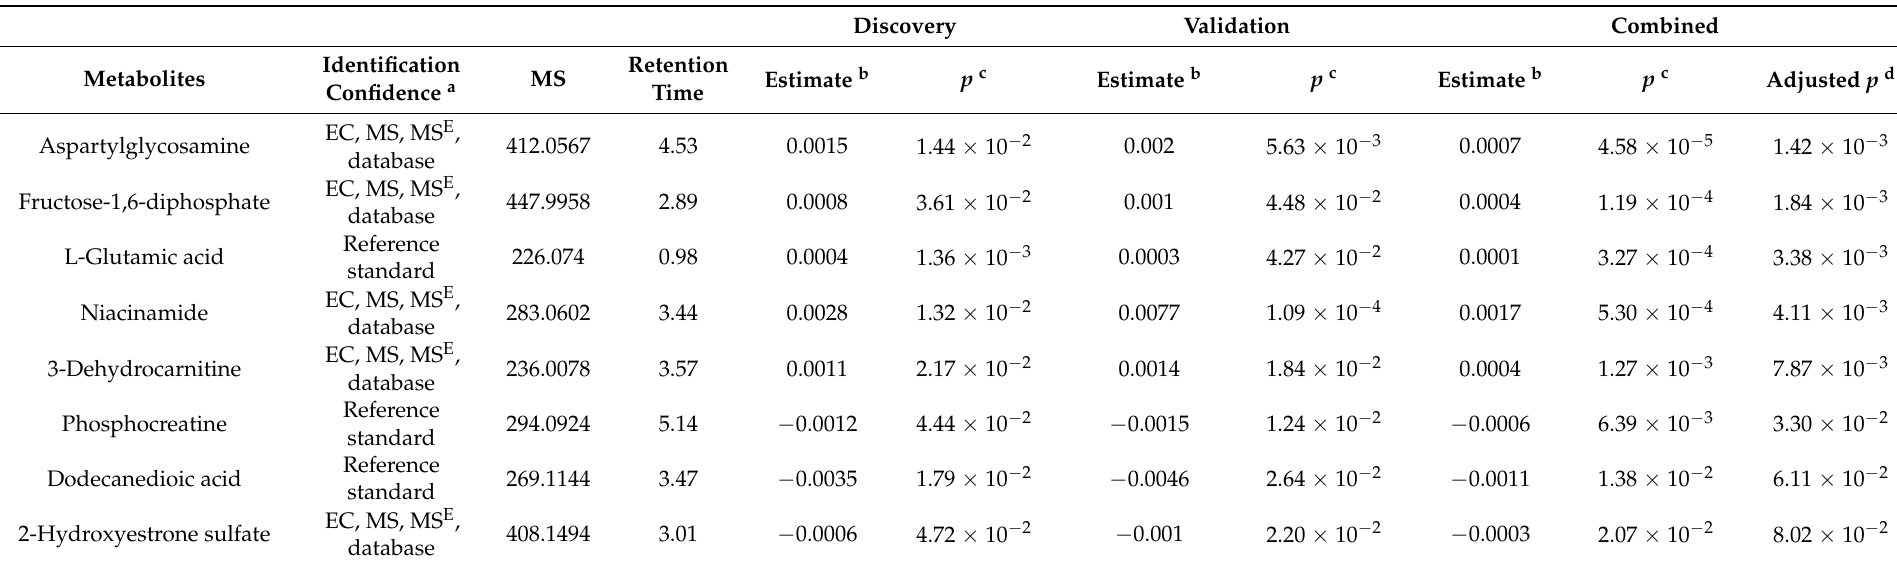
Table 3. Linear regression results showing associations between metabolites and blood